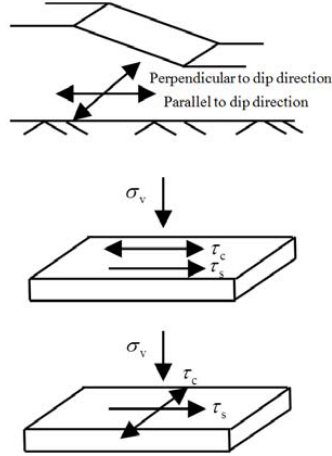
Figure 6. Two dynamic loading conditions considered in the tests (Reprinted from [38]).